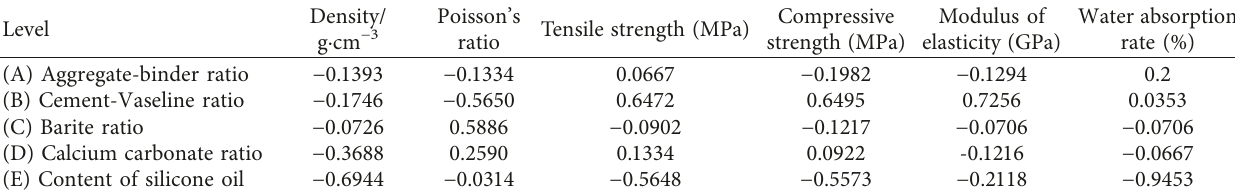
Table 3: Spearman correlation coefficient.